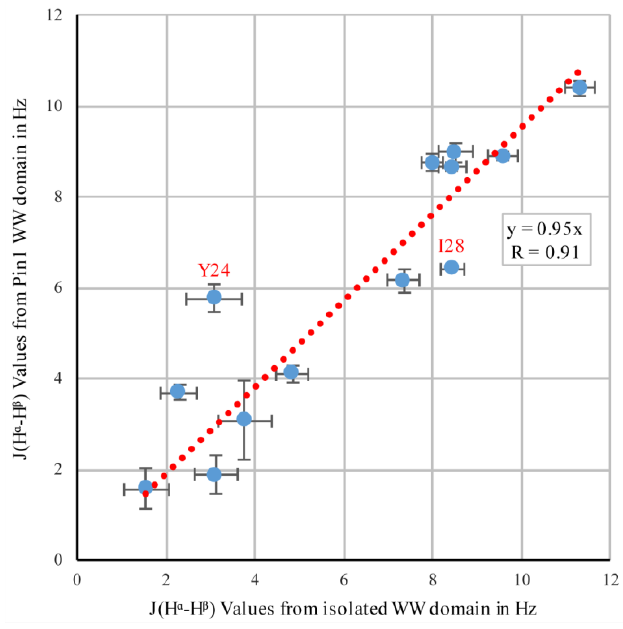
Figure 7. Correlation between 3 J Hα–Hβ coupling values in the isolated WW domain, and the